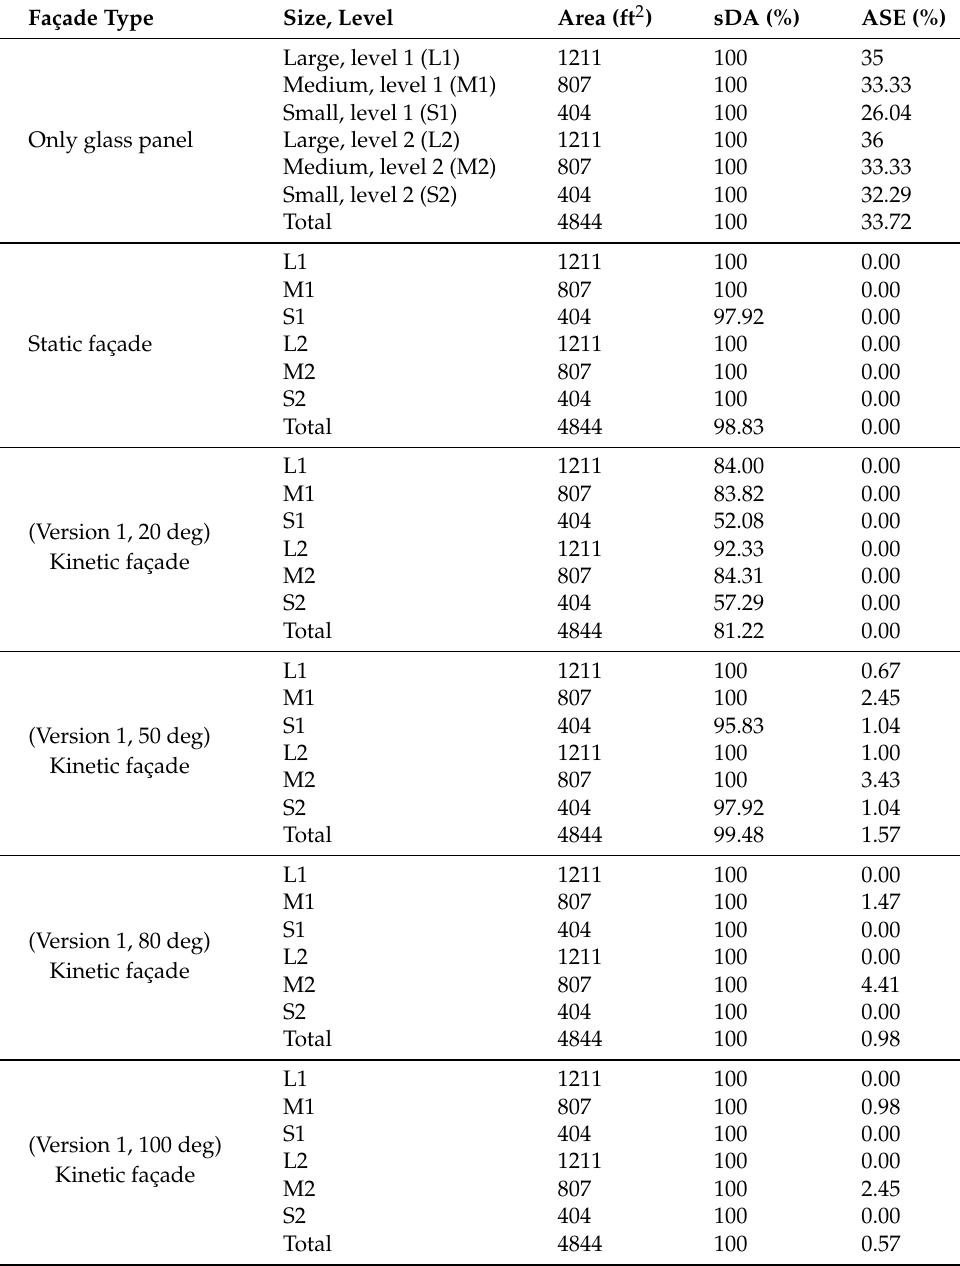
Table 2. The results after the simulation of the glass panel alone, the results after the simulation of the kinetic façade (version 2: twisting movement) in terms of LEED version 4.1 criteria for the static façade, and the kinetic façade (version 1: rotating movement) in terms of LEED version 4.1 criteria. Façade Type Size, Level Area (ft 2 ) sDA (%) ASE (%) Large, level 1